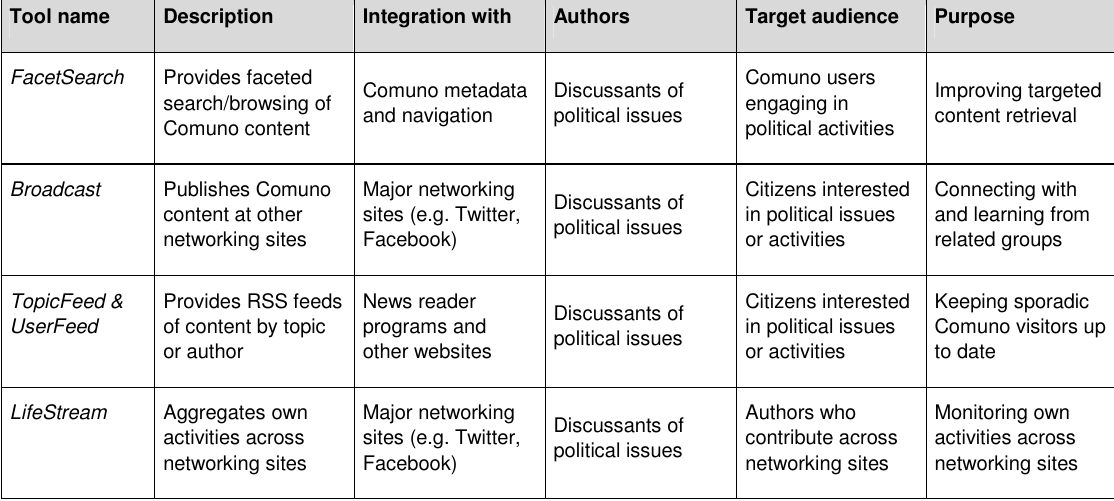
Table 1: Comuno tools for collaborating across networking